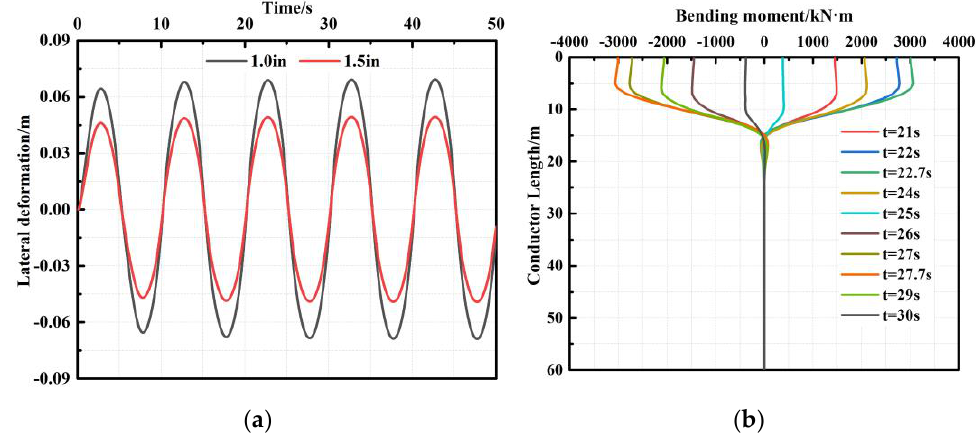
Figure 15. The influence of the W.T. on the mechanical response of the conductor, where ( a ) is the variation of the lateral moment at the top of the conductor with time and ( b ) is the variation of the bending moment along the conductor axial direction when the O.D. and W.T. are 36 in and 1.5 in, respectively.